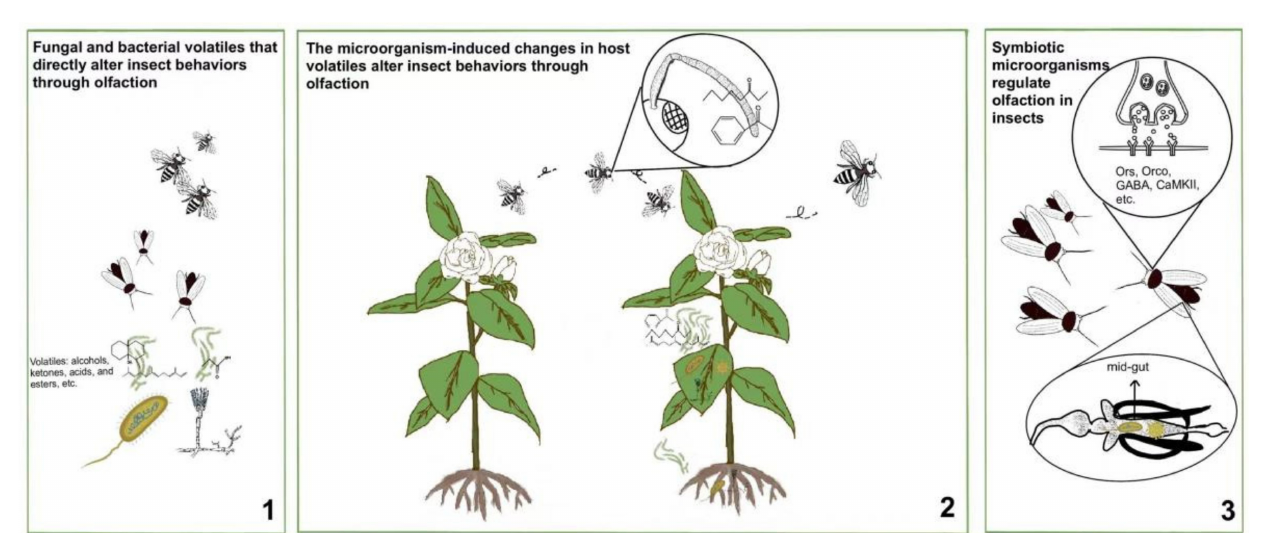
Figure 1. Microorganisms modulate insect behaviors via olfactory cues by different ways. 1 Fungal and bacterial volatiles that directly alter insect behaviors through olfaction. 2 The microorganism- induced changes in host volatiles alter insect behaviors through olfaction. 3 Symbiotic microorganisms regulate olfaction in